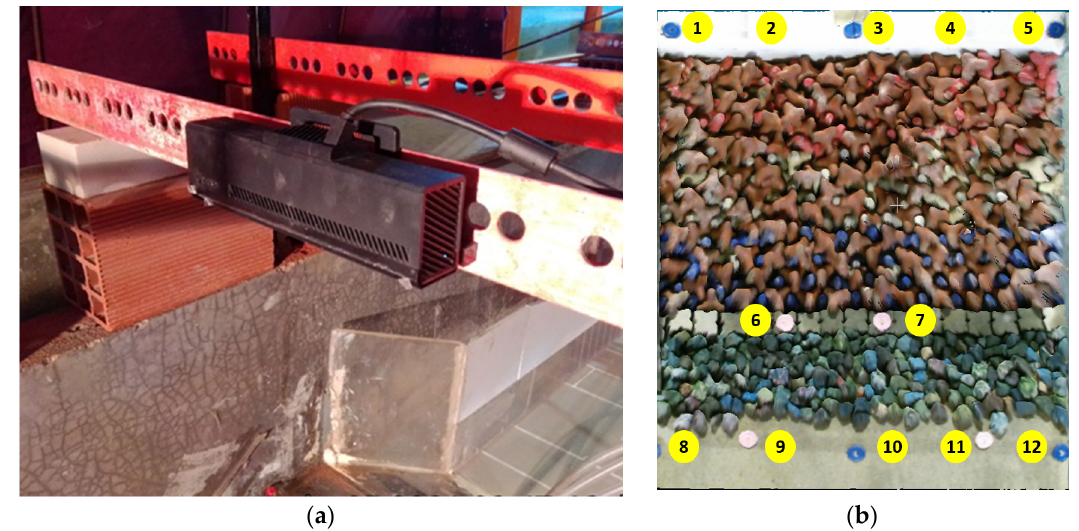
Figure 4. ( a ) Position sensor Kinect; ( b ) ground control points.